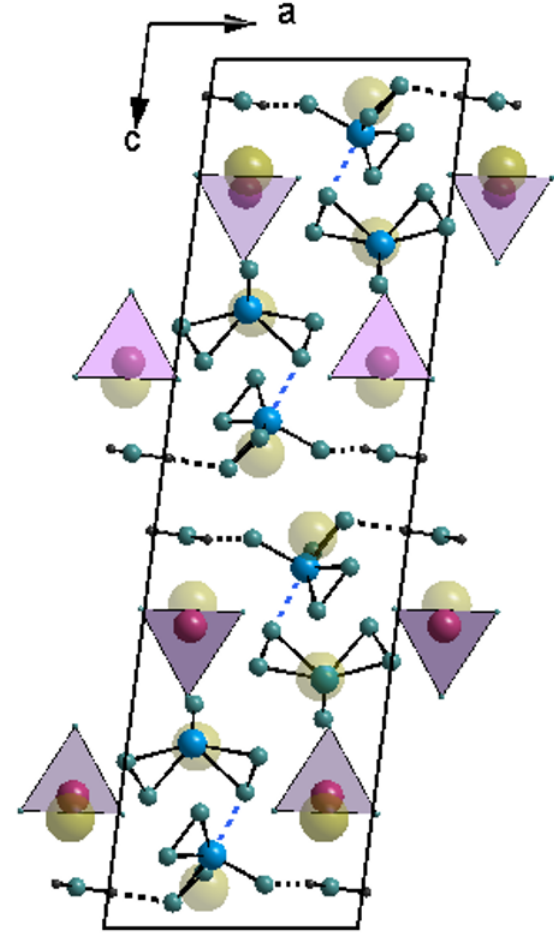
Figure 4. View of the structure along the b axis. Large balls represent potassium atoms and violet triangles IO 3– anions. Hydrogen bonds are indicated by black and weak V–O–V bonds by blue dashed lines.